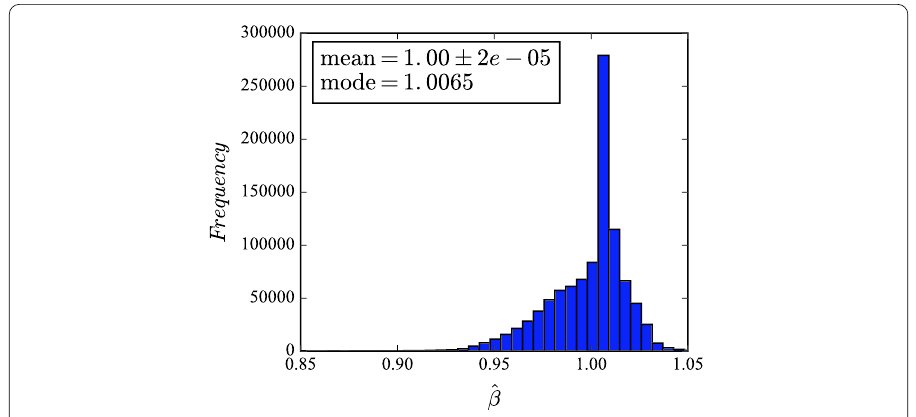
Figure 10 Distribution of ˆ β obtained form 1,000,000 estimations of the RANSAC algorithm, using OLS as the underlying